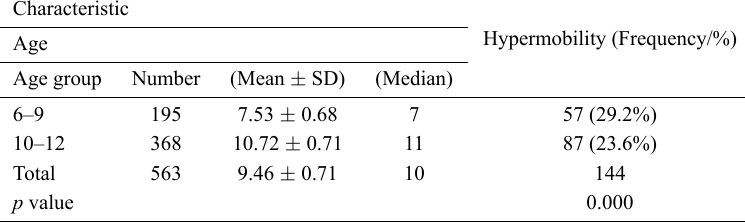
Table 3. Generalized joint hypermobility and age groups.